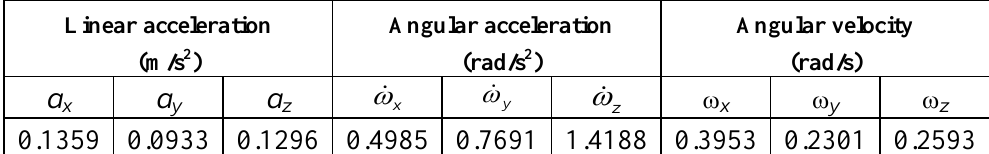
Figure 10. Comparison of states obtained from the traditional IMU (thick black dashed line) and the 12-axis IMU (thin red solid line): ( a ) linear acceleration, ( b ) angular acceleration, and ( c ) angular